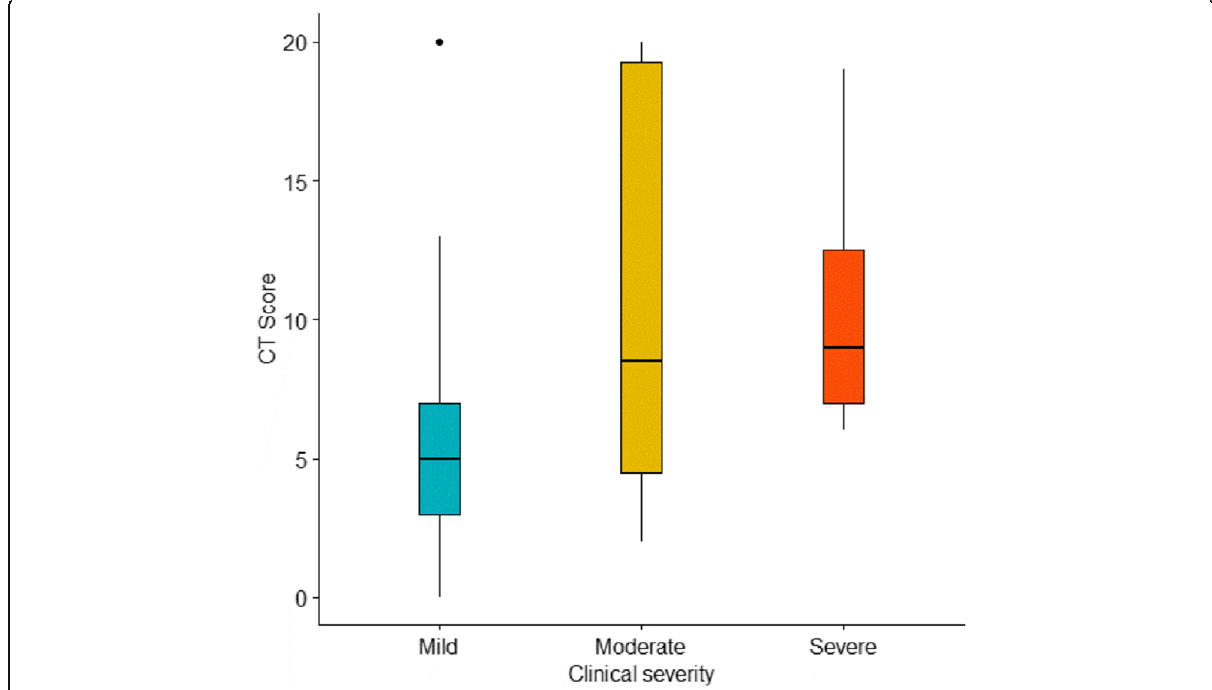
Fig. 2 CT severity score compared among the three groups (mild/moderate/severe)